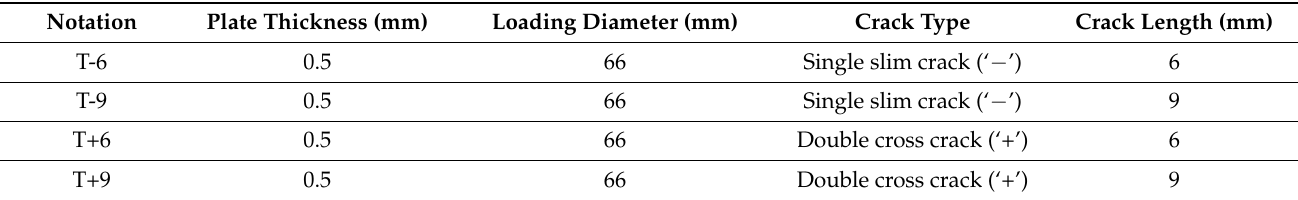
Table 12. Summarized findings of the sensor-based research on measuring impact and shock